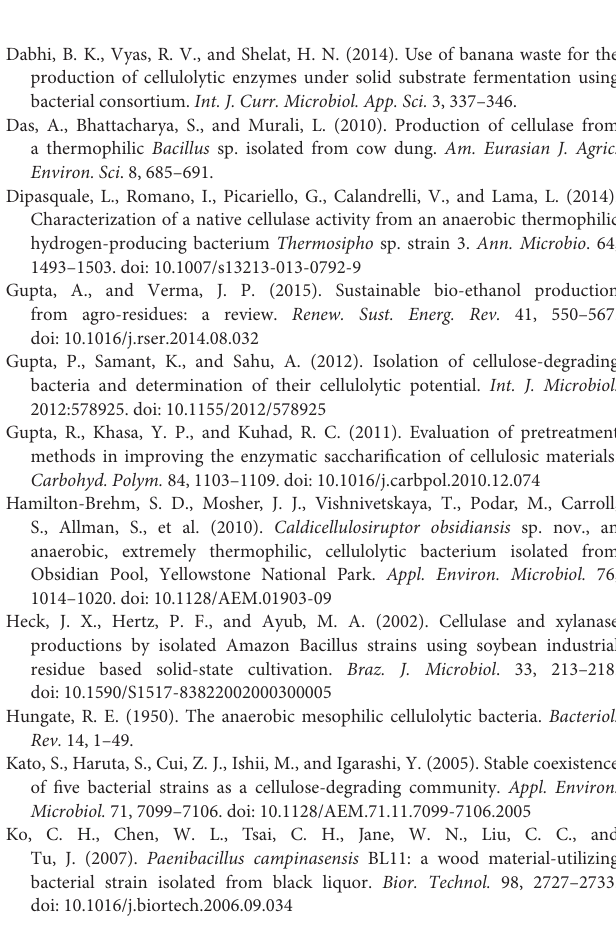
Supplementary Figure 1 | Pre-treated wheat straw and sugarcane bagasse used as substrate. Supplementary Figure 2 | External morphology of the identified bacterial strains. Supplementary Figure 3 | Biochemical analysis of the bacterial strains. Supplementary Figure 4 | CMC hydrolysis of the bacterial strains of CMC-congo red plates. Supplementary Figure 5 | Phylogenetic tree of the molecularly identified bacterial strains. The phylogenetic tree between 39 taxa was generated using the UPGMA